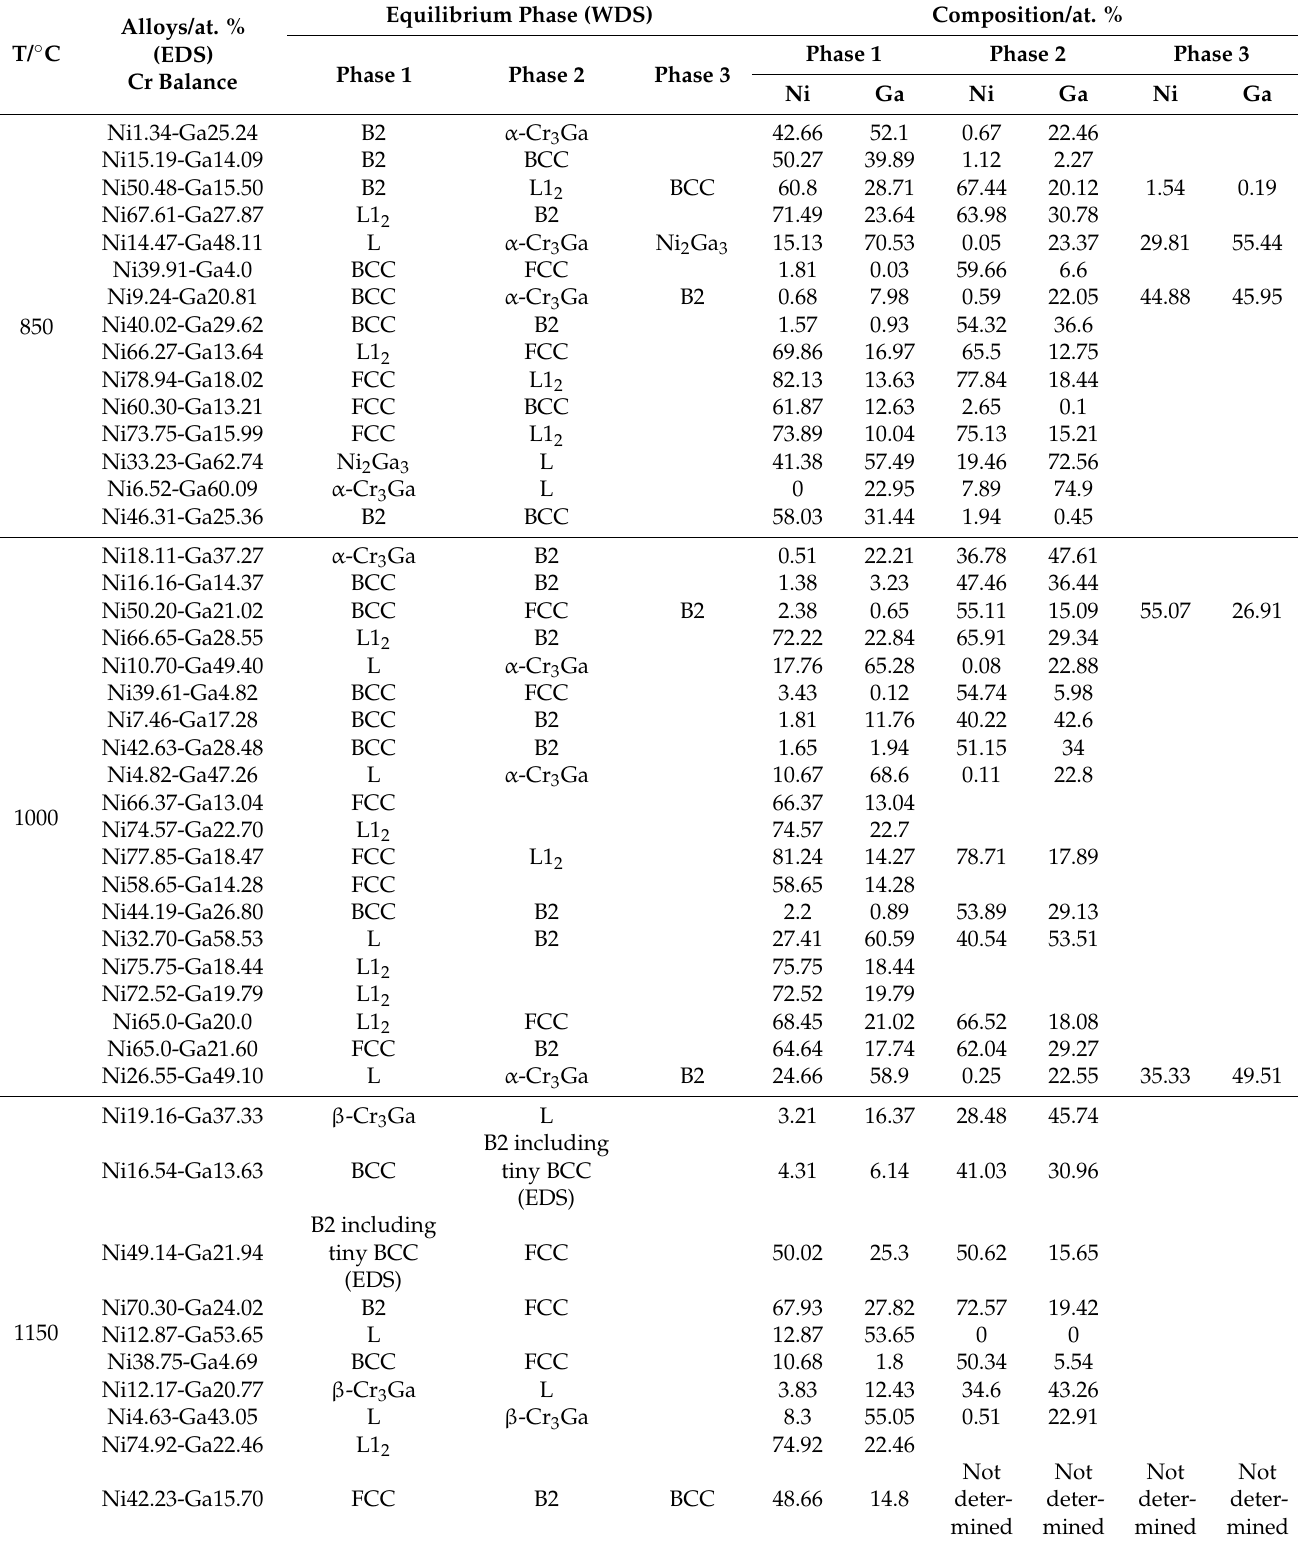
Table 1. The measured chemical compositions of the equilibrium phase in the annealed